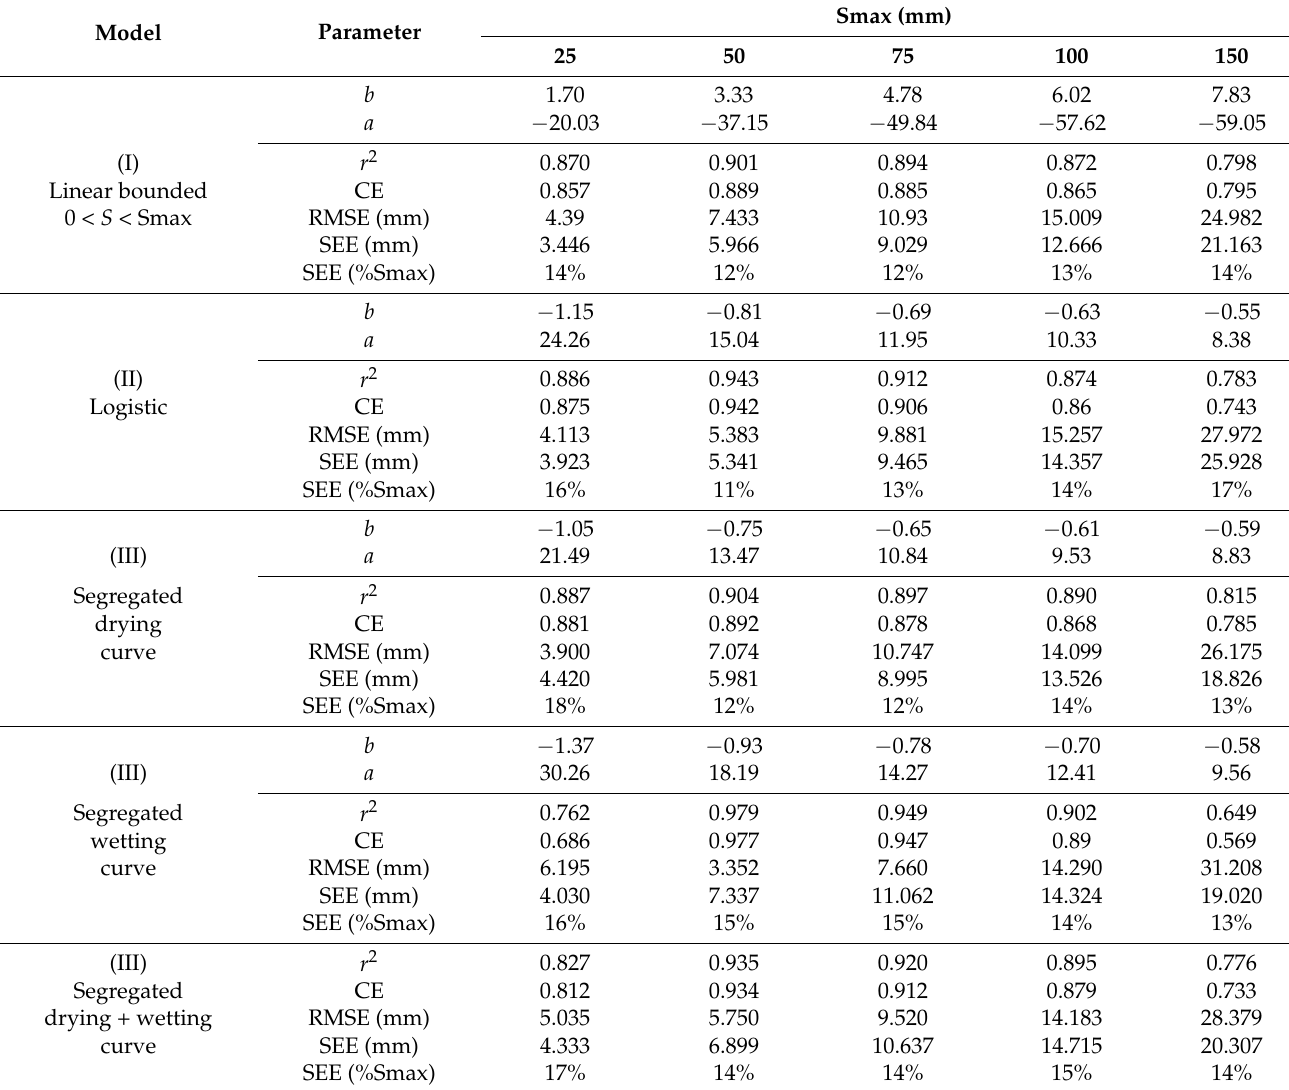
Table 4. Regression parameters and performance indicators of models I, II and III, which were applied with different soil water storage capacities, Smax: outlier-removed data series obtained using the interquartile range rule (SM, %, independent variable; S , mm, dependent variable; n =